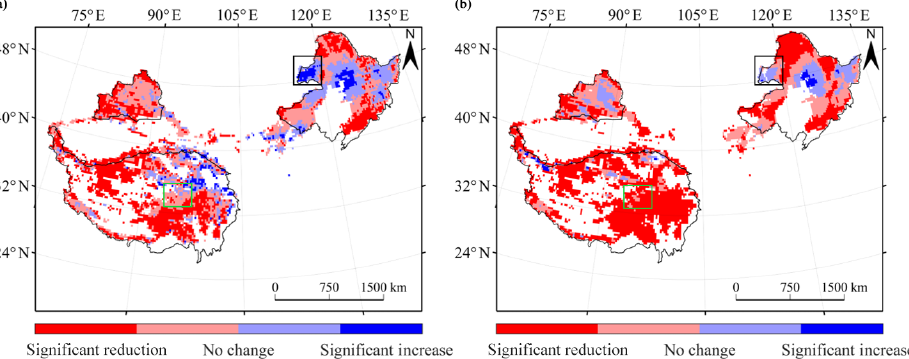
Figure 12. Trend analysis of snow depth during the period 1987–2018: (a) RF product; (b) WESTDC data. Light red and light blue represent no significant trend